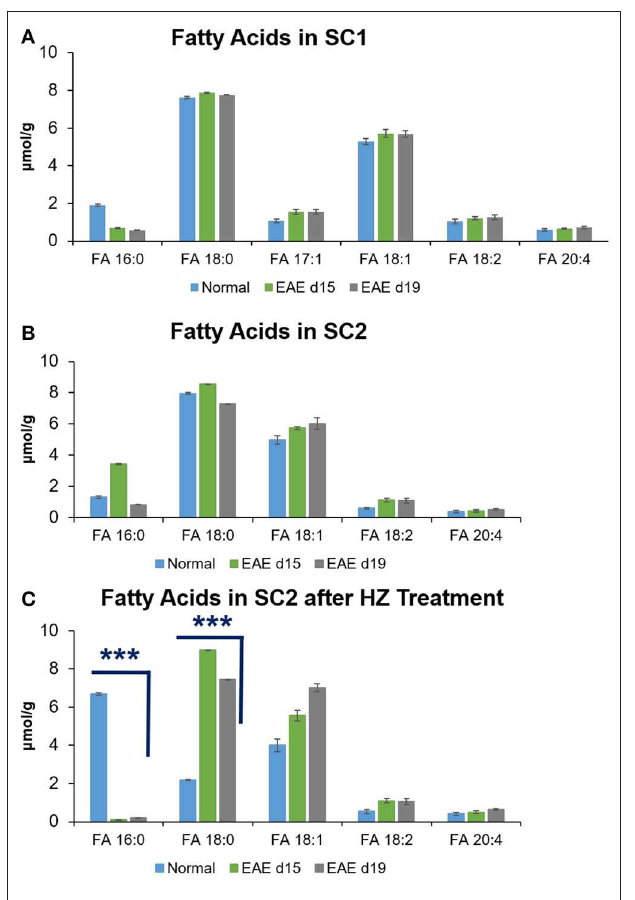
FIGURE 3 | Quantitation of saturated and unsaturated FAs in mouse spinal cords of (A) SC1, (B) SC2, and (C) SC2 after HZ treatment. Error bars represent standard deviation, n = 5. Differences between the mouse spinal cords were confirmed via two-tailed Student’s t -test (*** p < 0.0005).